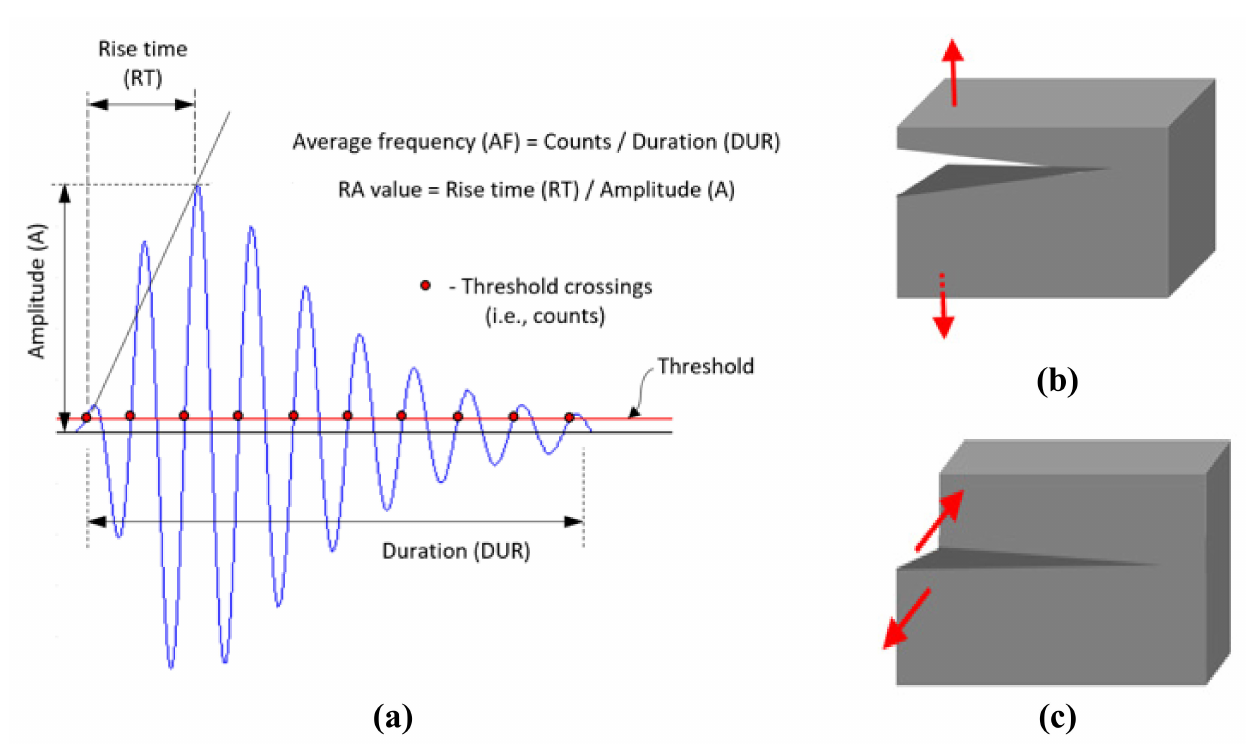
Figure 1. Schematic representation of ( a ) an AE signal and some important AE parameters, ( b ) tensile crack, and ( c ) shear